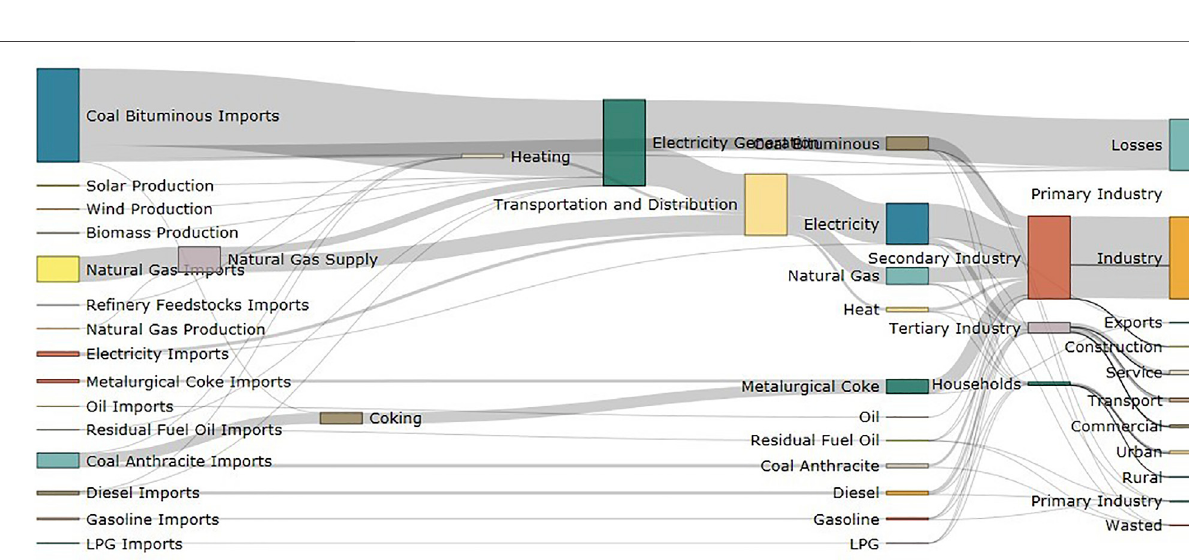
FIGURE 9 | Energy fl ows in 2050 under the BAU